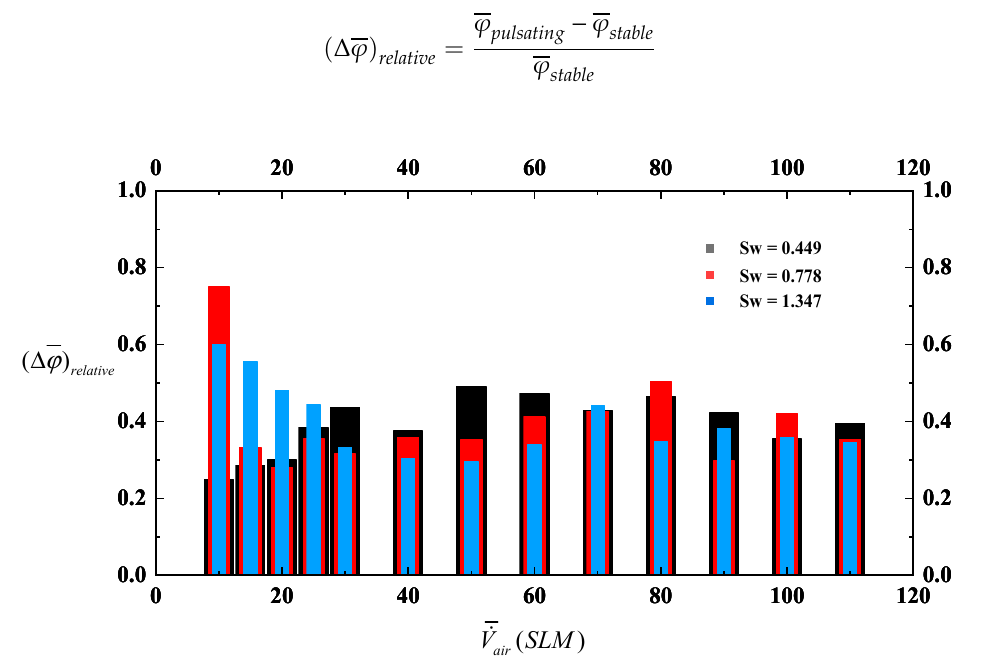
Figure 10. ( a ) The lean blowout limits in stable flow mode; ( b ) The lean blowout limits in pulsating flow mode.